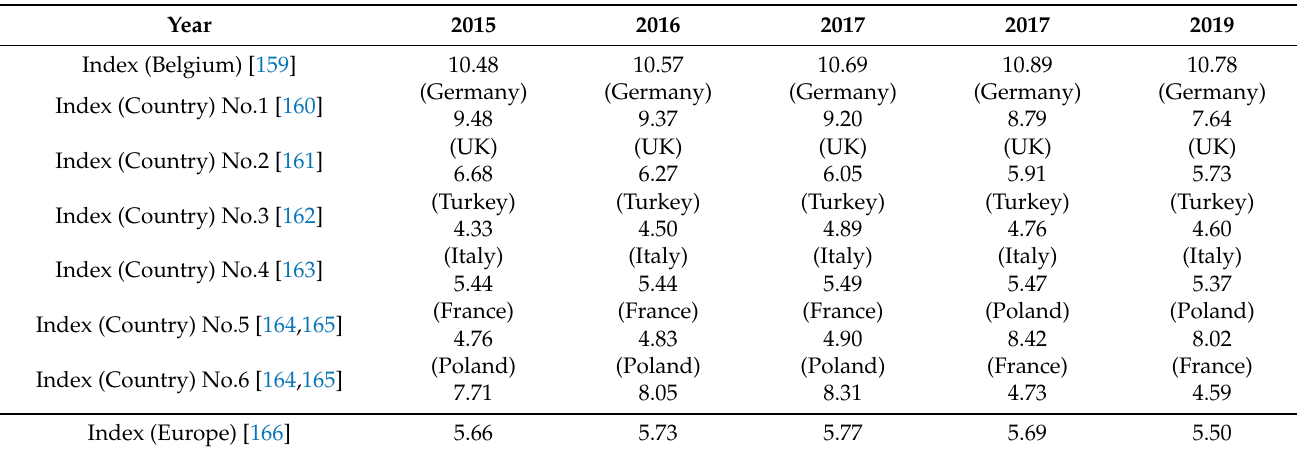
Figure 19. Historical values of produced CO 2 in Belgium [158]. Table 5. Historical values of CO 2 emission per capita